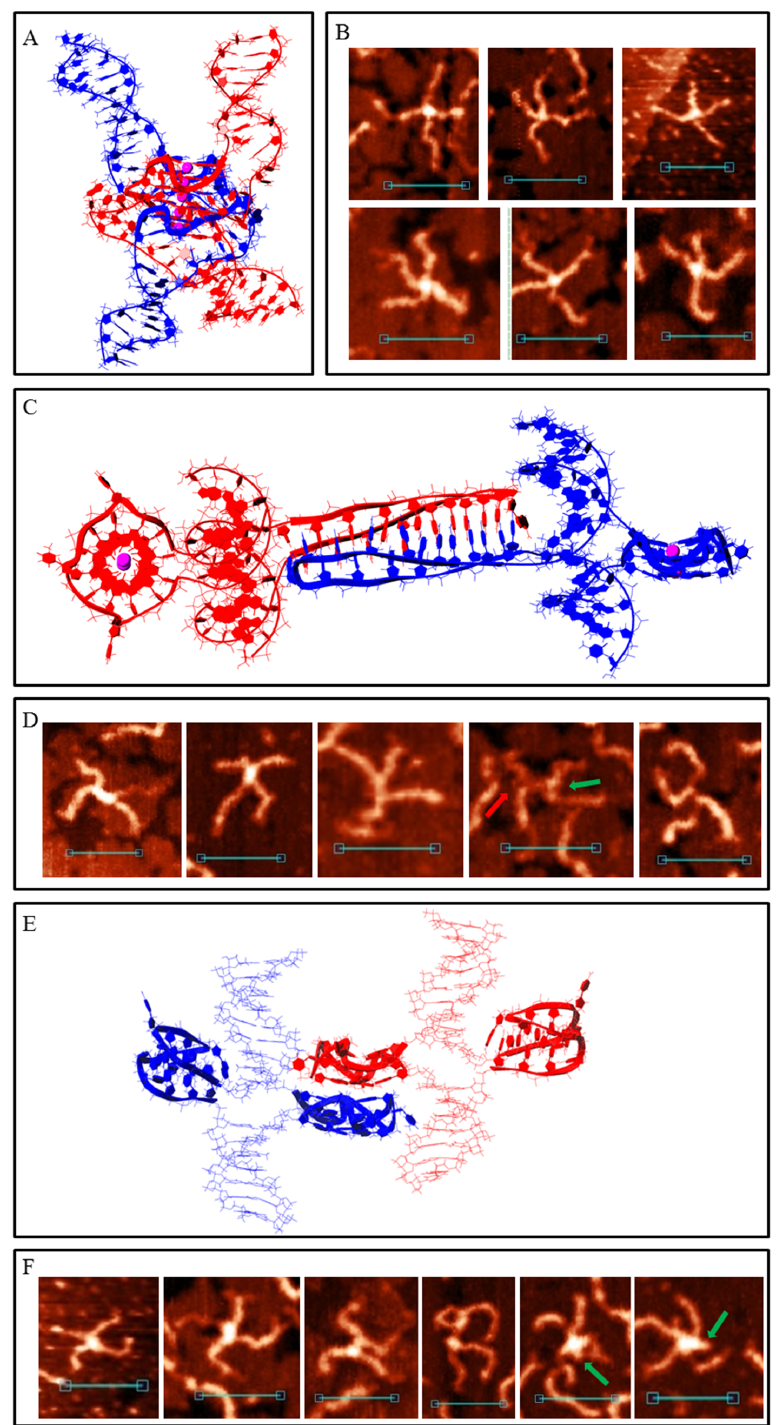
Figure 5. Bimolecular G4/IM-synaptic complexes formed by 4m sample. ( A ) Molecular model of duplex joining through interlocked G4-dimer folding. ( B ) Examples of the complexes, consistent with model ( A ), revealed by AFM. Scale bars: 50 nm. ( C ) Molecular model of duplex joining through two intermolecular IMs. ( D ) Examples of the complexes, consistent with model ( B ), revealed by AFM. Red arrow indicates the free G-rich chain, and green arrow indicates the folded G4 structure. Scale bars: 50 nm. ( E ) Molecular model of duplex joining through stacking of intramolecular G4s. ( F ) Examples of the complexes, consistent with model ( E ), revealed by AFM. Green arrows indicate folded IM structures. Scale bars: 50